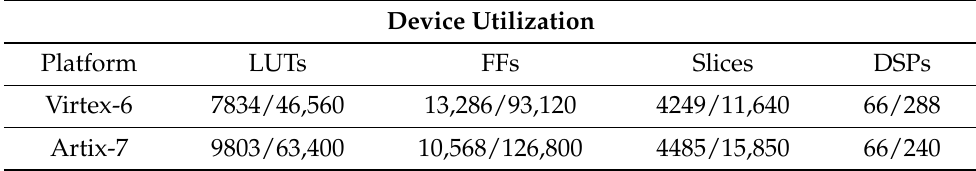
Table 4. Resources used by the FPGA for the proposed Modular Exponentiation.